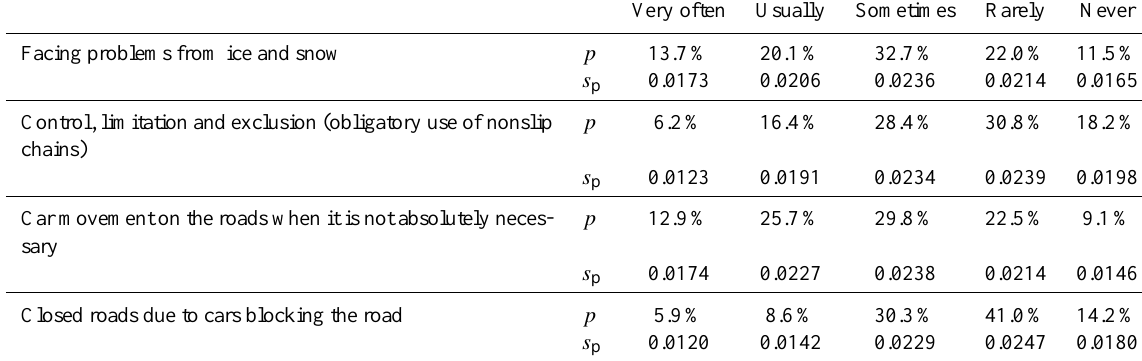
Very often Usually Sometimes Rarely Never